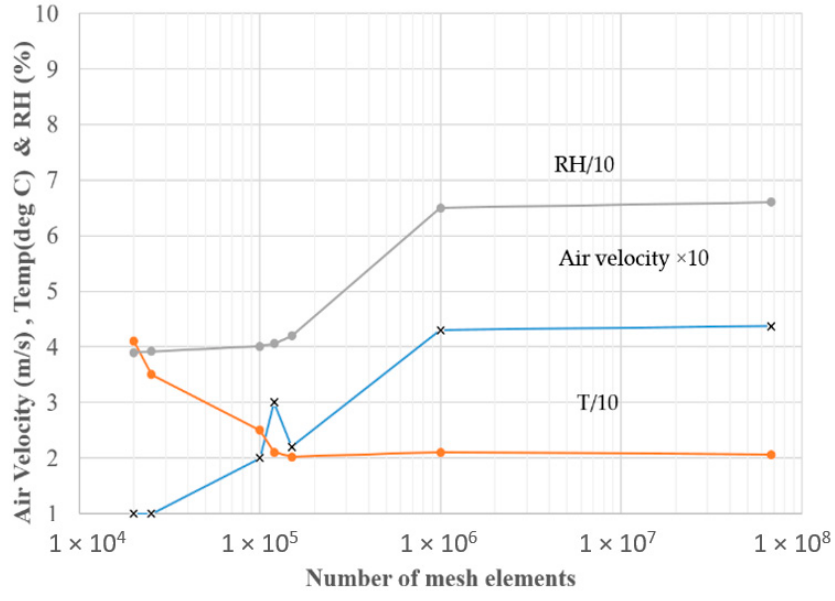
Figure 5. Grid independence study showing the effect of the Air velocity (blue), Temperature (orange) and Relative humidity (gray) as a function of the total number of elements present in the domain. Eventually, a mesh of 10 6 cells were used for faster converged solutions.